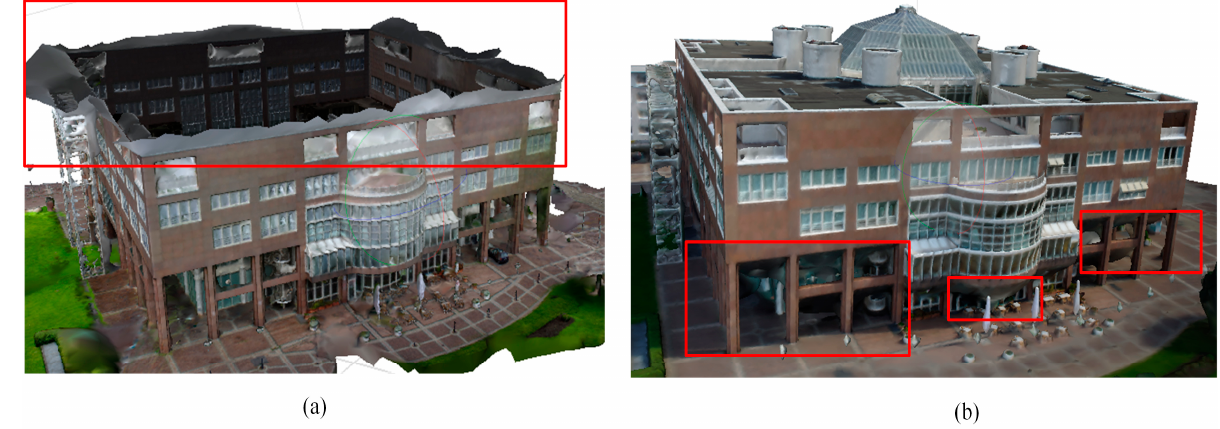
Figure 1. Reconstructed models from images collected from different perspectives. ( a ) The ground model. ( b ) The aerial model.